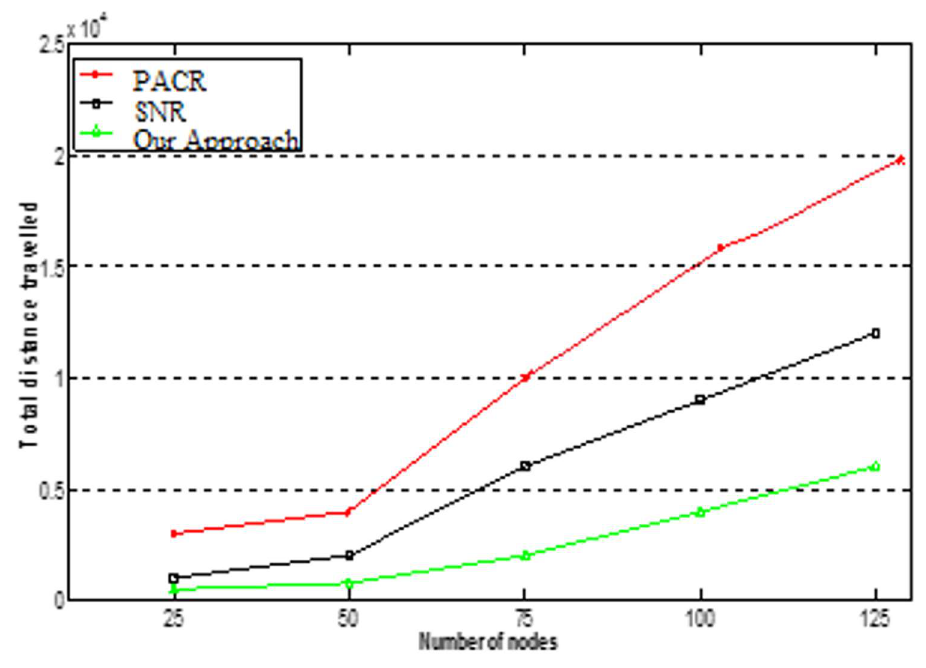
Figure 2. Number of nodes vs. distance travelled.